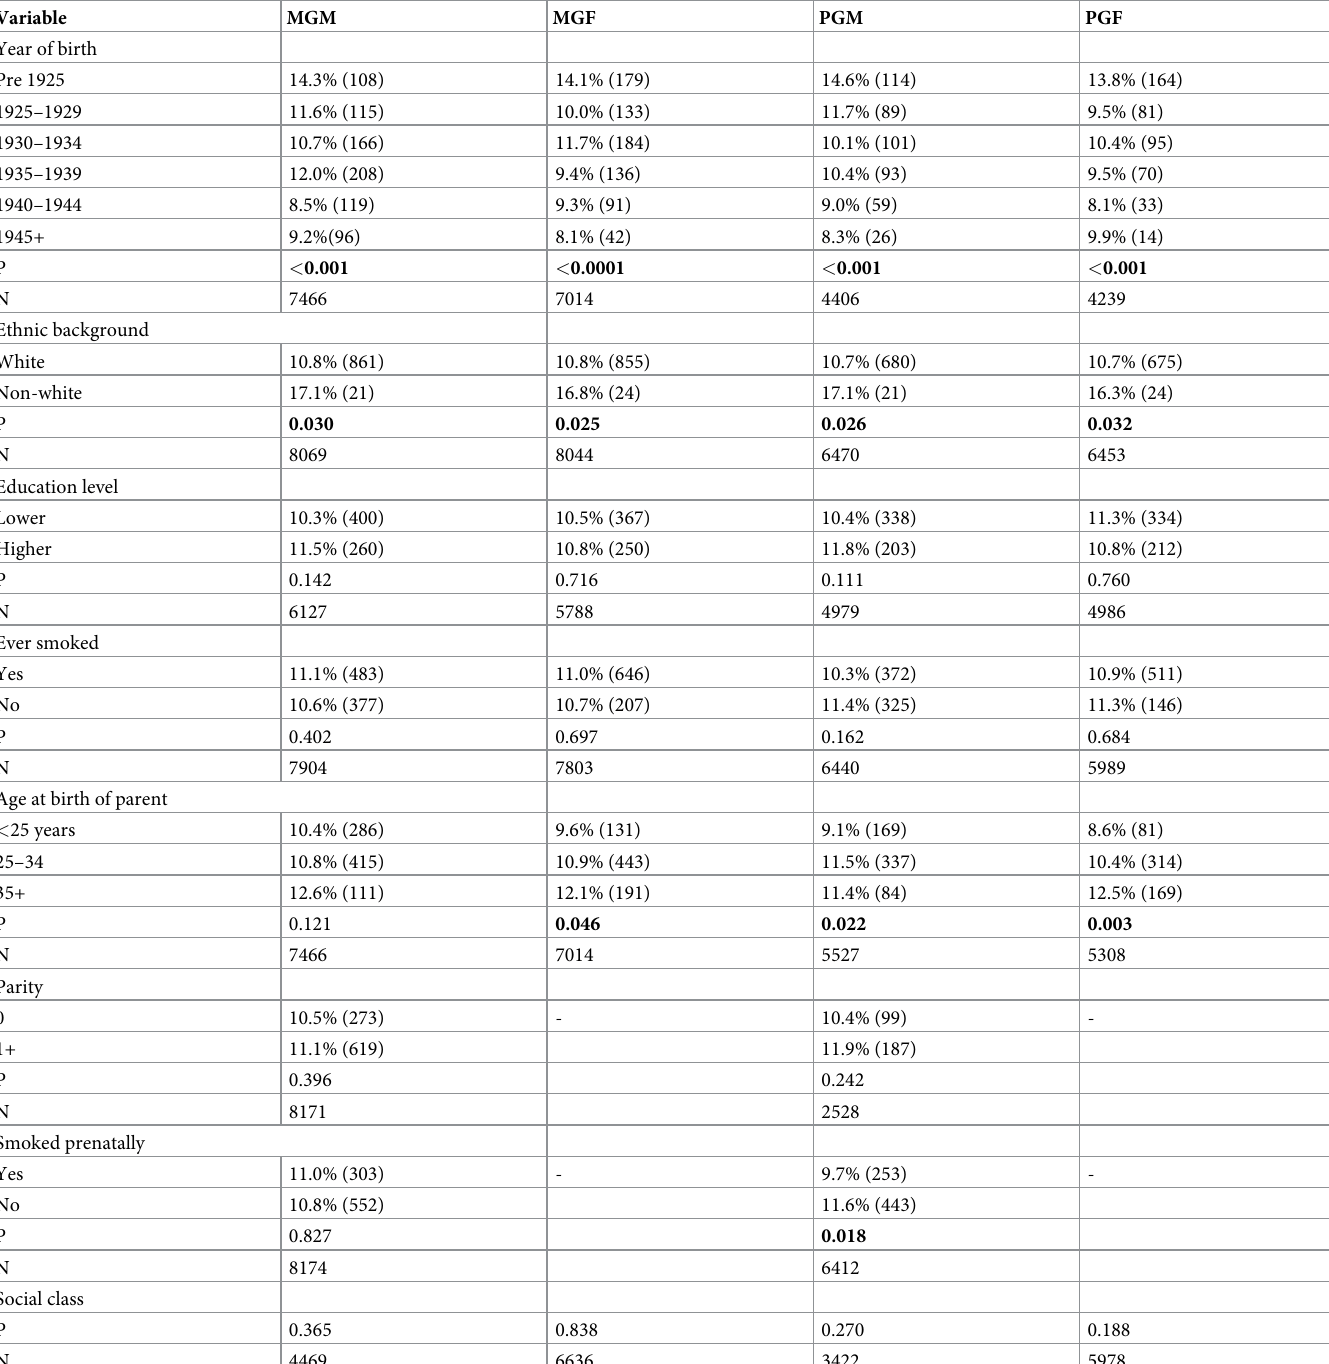
Table 2. Proportion (n) of children who hated loud noises at age 6 according to features of their grandparents. [P values < 0.10 are in bold].